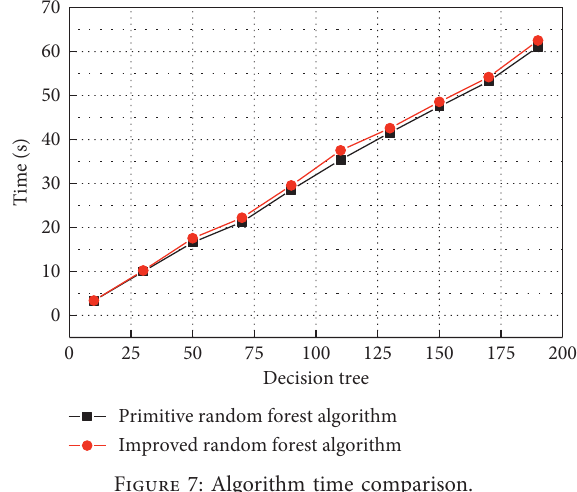
Figure 7: Algorithm time comparison.